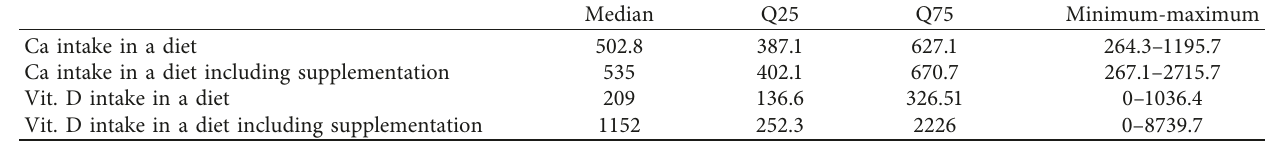
Table 1: Intake of calcium (mg) and vitamin D (IU) in a diet, including supplementation.